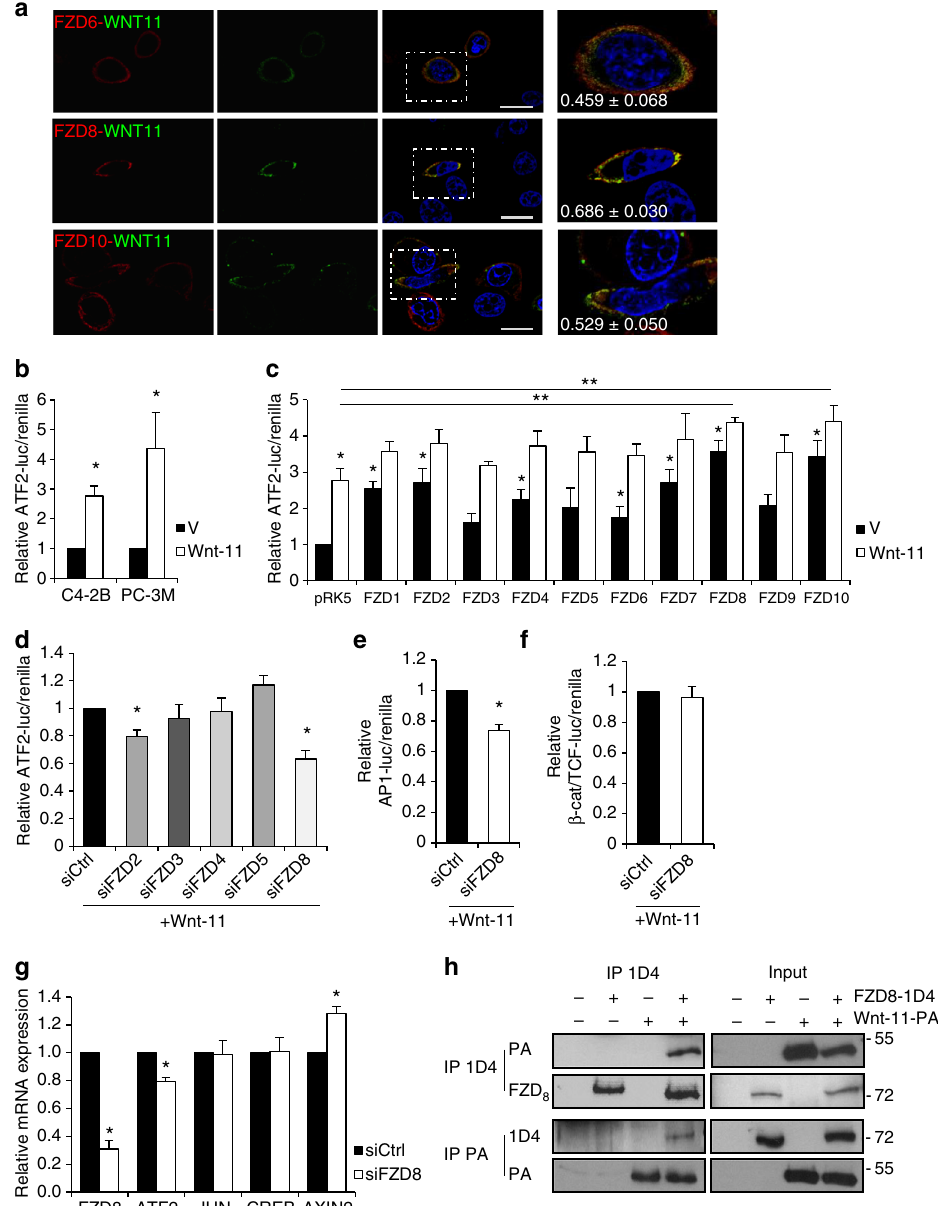
Fig. 1 FZD8 is required for Wnt-11/ATF-2 signaling in prostate cancer. a Confocal microscopy analysis of PC-3M cells transfected with 1D4-tagged FZD 6 , FZD 8 , or FZD 10 (red) and Wnt-11 (green) for 24 h (for other FZD family members, see Supplementary Fig. 2); low magni fi cation images of single color and dual channels and high magni fi cation images of single cells are shown; anti-1D4 and goat anti-Wnt-11 (R&D) were used to detect FZDs and Wnt-11, respectively; blue staining shows cell nuclei (DAPI), images are representative of three independent experiments, scale bars 25 µ m. Quanti fi cation of colocalization was determined by ImageJ (see Methods) using 10 cells per experiment. Numbers in the images correspond to average Pearson correlation coef fi cient -/ + standard deviation. b Relative ATF2 luciferase/renilla activity in C4-2B and PC-3M cells transfected with empty vector pcDNA (V) or Wnt- 11; results are normalized to empty vector. c Relative ATF2 luciferase/renilla activity in C4-2B cells transfected with empty vector pRK5 (V) or Wnt-11 and FZD 1-10; results are normalized to empty vector. d Relative ATF2 luciferase/renilla activity in PC-3M cells transfected with control siRNA (siCtrl) or the indicated siRNAs and then with Wnt-11; results are normalized to siCtrl. e Relative AP1 luciferase/renilla activity in PC-3M cells transfected with siCtrl or siFZD8 and then with Wnt-11; results are normalized to siCtrl. f Relative β -catenin/TCF activity (TOPFlash/FOPFlash) in PC-3M cells transfected with siCtrl or siFZD8 and then with Wnt-11; results are normalized to siCtrl. g Q-PCR analysis showing mRNA expression of the indicated genes, relative to 36B4, in PC-3M cells transfected with control (siCtrl) and FZD8 siRNAs. h Western blots of anti-1D4 and anti-PA immunoprecipitates (IP) and extracts (Input) from PC-3M cells transfected with 1D4-tagged FZD 8 and PA-tagged Wnt-11 plasmids. Extracts were probed with PA, 1D4, or FZD 8 (LS bio) antibodies; blots are representative of three independent experiments. Error bars in b – g show SD from four independent experiments (* p < 0.05, ** p < 0.001 by Student's t- test or ANOVA with Tukey post hoc test where